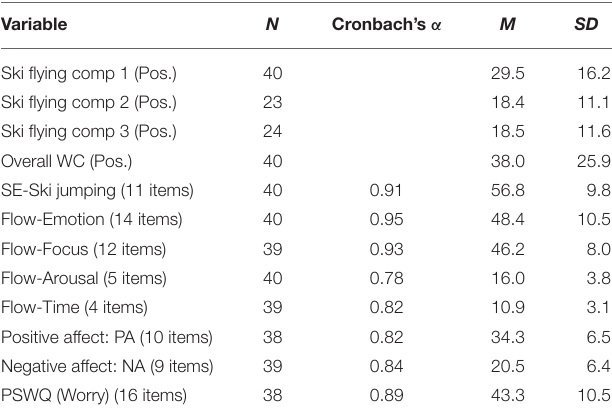
TABLE 2 | Descriptive statistics of study